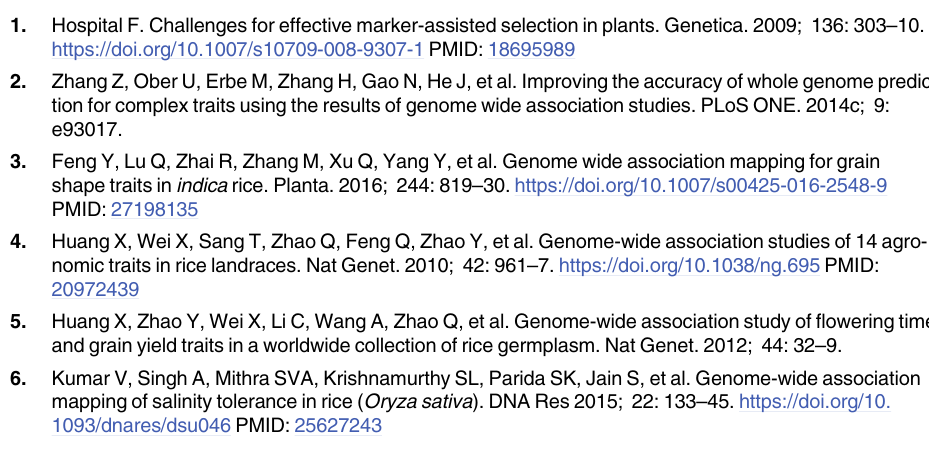
S1 Table. Rice varieties from different origins and subspecies used in the association analy-